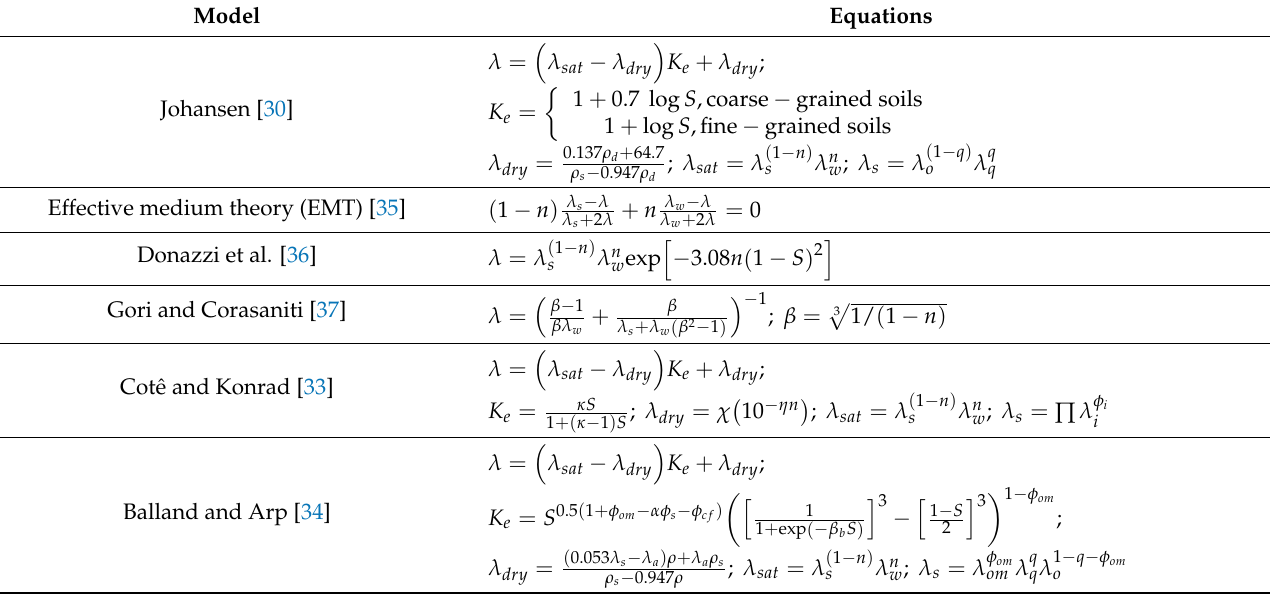
Table 1. Evaluated thermal conductivity models for different types of soils a . Model